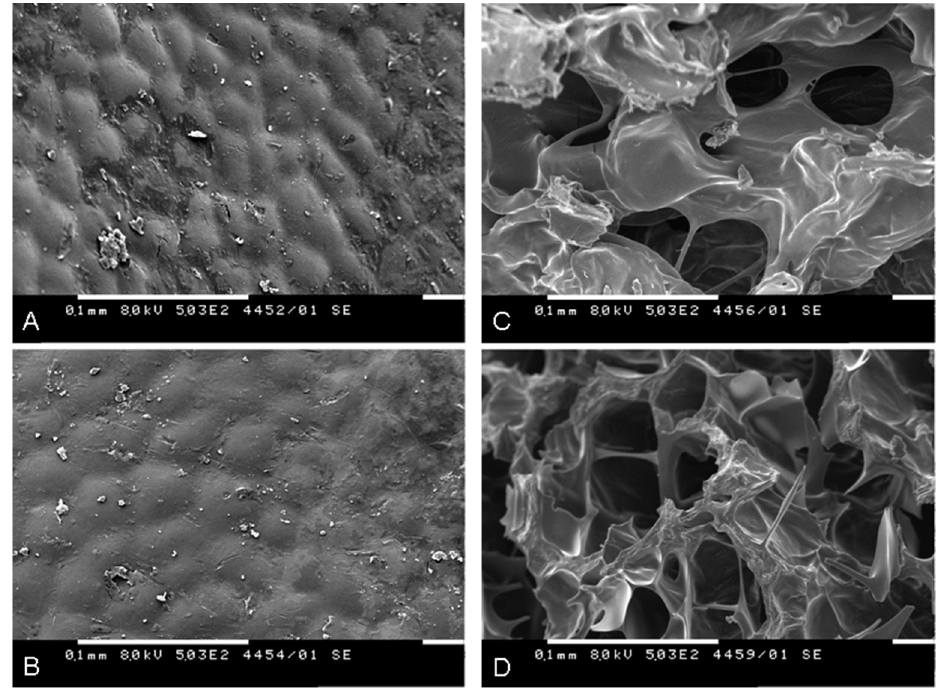
Figure 5. SEM images of the surface of non-irradiated ( A ) and 25 kGy-irradiated ( B ) RH fruit, and the internal part of non-irradiated ( C ) and 25 kGy-irradiated ( D ) RH fruit (8 kV, 0.1 mm, 500 × ).